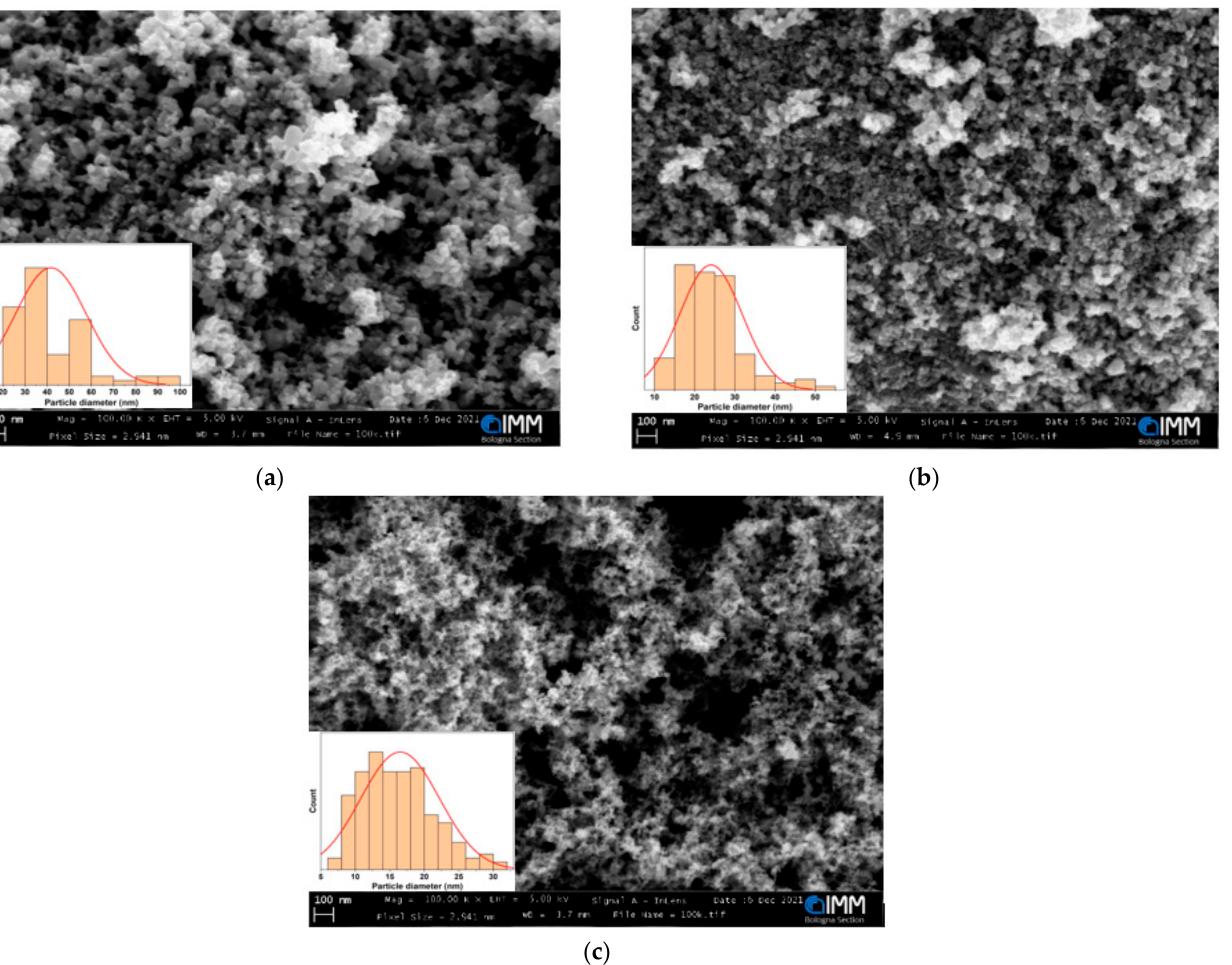
Figure 2. SEM images of ( a ) S1; ( b ) ATO1 and ( c ) ATO2 at 250 kX magnification. Insets are the histograms of grain size distribution for sample S1 ( a ), ATO1 ( b ) and ATO2 ( c ).